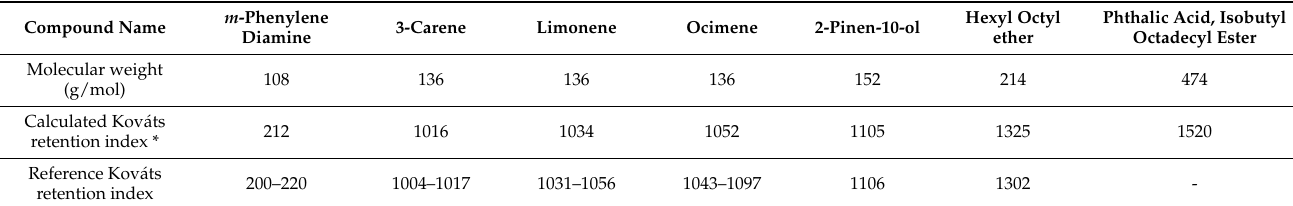
Table 1. Common names of detected VOCs and their Kov á ts retention